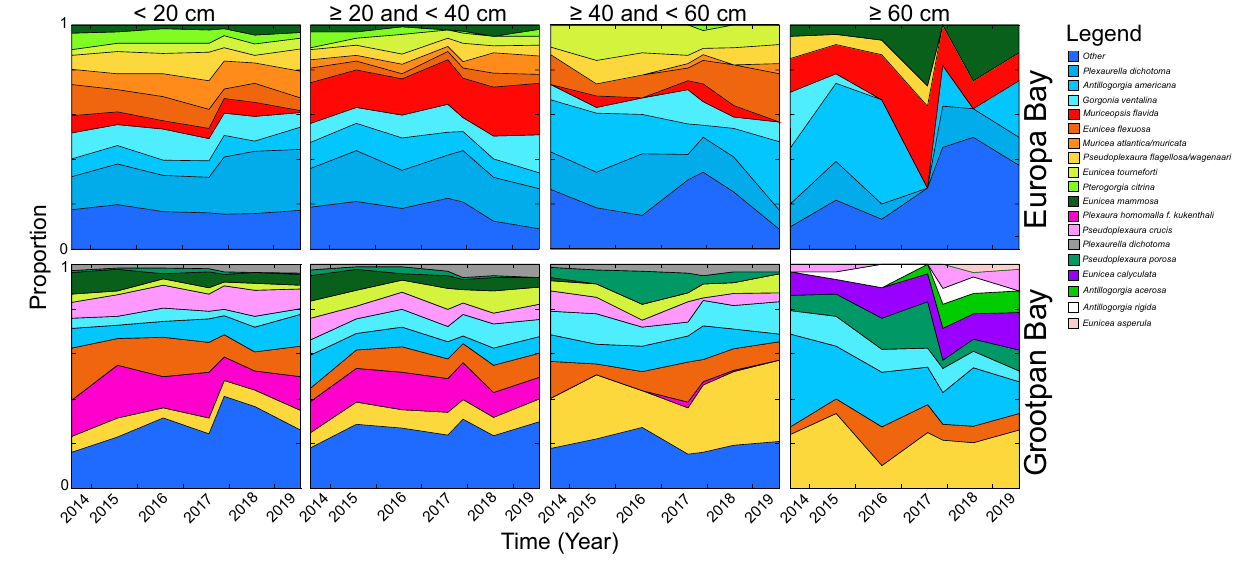
Figure 6. Proportional representation of the 10 most common octocoral species in four size classes at Europa Bay and Grootpan Bay in the 7 samplings described in this study. For Europa Bay, the most common 10 species were the same in each size class, but they varied among size classes for Grootpan Bay. Abscissa is plotted by sampling month, with two samplings in 2017, and axis marked in years. Sample sizes (number of colonies) by sampling at Europa Bay were: n = 176–266 for < 20 cm, n = 97–155 for ≥ 20 cm and < 40 cm, n = 23–52 for ≥ 40 cm and < 60 cm, and n = 8–23 for ≥ 60 cm; at Grootpan Bay: n = 112–261 for < 20 cm, n = 116–248 for ≥ 20 cm and < 40 cm, n = 67–146 for ≥ 40 cm and < 60 cm, and n = 24–54 for ≥ 60